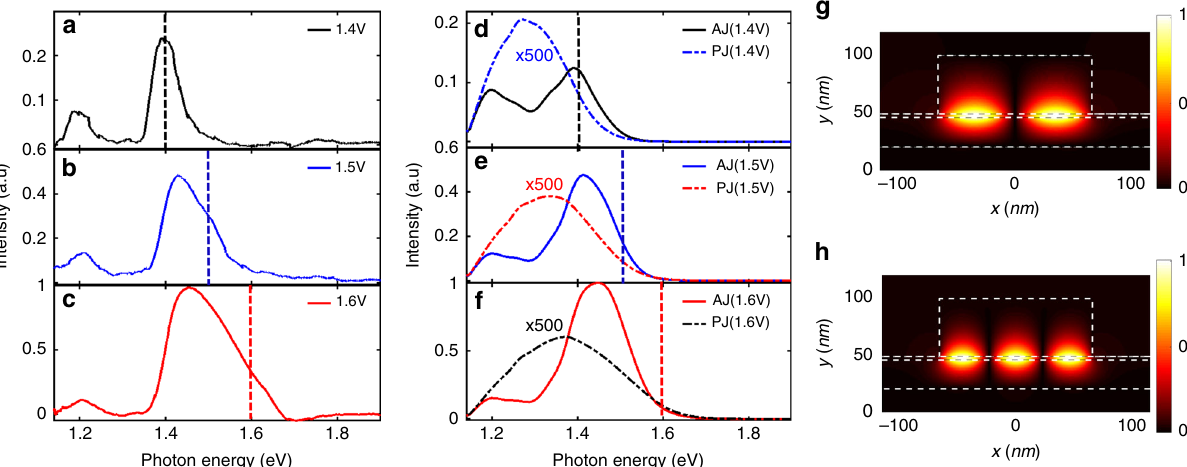
Fig. 4 Controlling the emission spectrum. a – c Experimental SPP emission spectra at three different biases (1.4 – 1.6 V, width of patch is around 128 nm, period of patch is 400 nm, spectra intensity have been normalized by the maximum power with the bias of 1.6 V); d – f theoretical normalized SPP emission spectra with same bias voltage as the fi gures ( a – c ). The emission spectrum shows two spectral peaks due to the excitation of two resonant modes of the antenna. The peaks are broadened due to the inhomogeneity of the antenna width. The simulations result from an average over seven different widths varying from 116 to 140 nm to account for width fl uctuations along the wires in the experiments. The dotted line in each fi gure shows the corresponding normalized spectrum from a planar junction with the same voltage bias (intensity of the spectra has been multiplied by a factor of 500). All the theoretical emission spectra are corrected by the quantum ef fi ciency of the spectrometer responsible for the decay at low energies. g , h Theoretical magnetic fi eld distribution 54 ( H y in the X – Z plane) of the two gap modes of a 132-nm-wide antenna corresponding to the lower photon energy at 1.2 eV ( g ) and the higher photon energy at 1.5 eV ( h